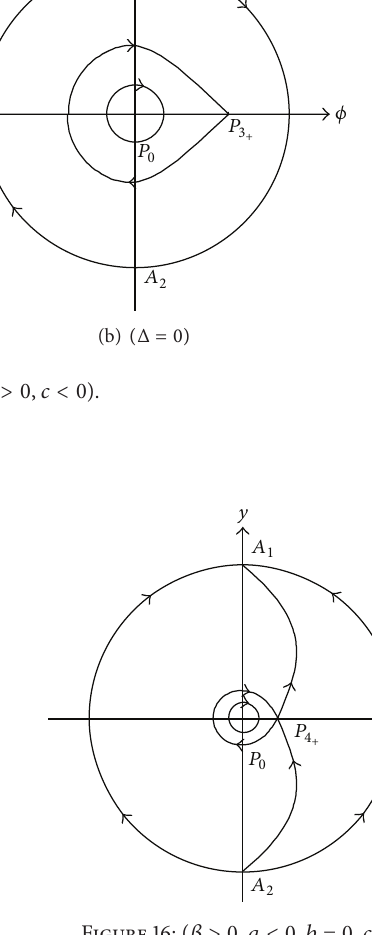
Figure 15: ( 𝛽 > 0 , 𝑎 < 0 , 𝑏 = 0 , 𝑐 > 0 ). Figure 16: ( 𝛽 > 0 , 𝑎 < 0 , 𝑏 = 0 , 𝑐 < 0